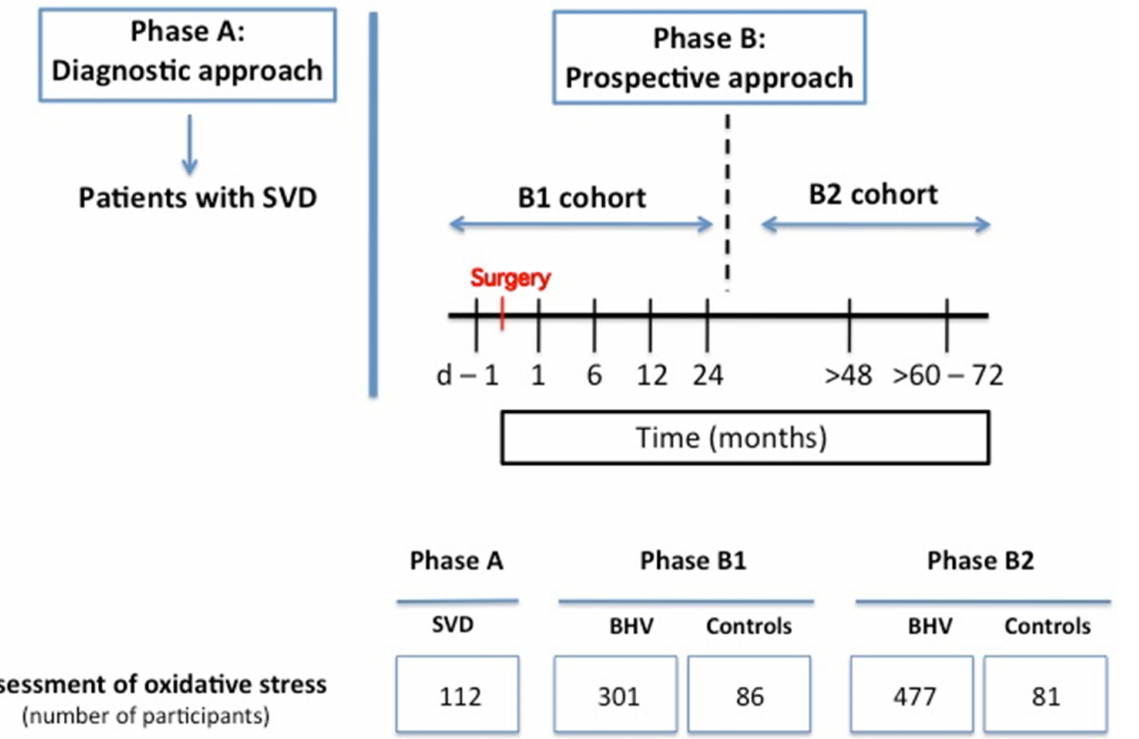
Figure 1. ( a ) Study protocol diagram (SVD—structural valve deterioration). See text for details. ( b ) Chart showing the number of patients recruited for the assessment of oxidative stress in the different phases and study groups (BHV, bioprosthetic heart